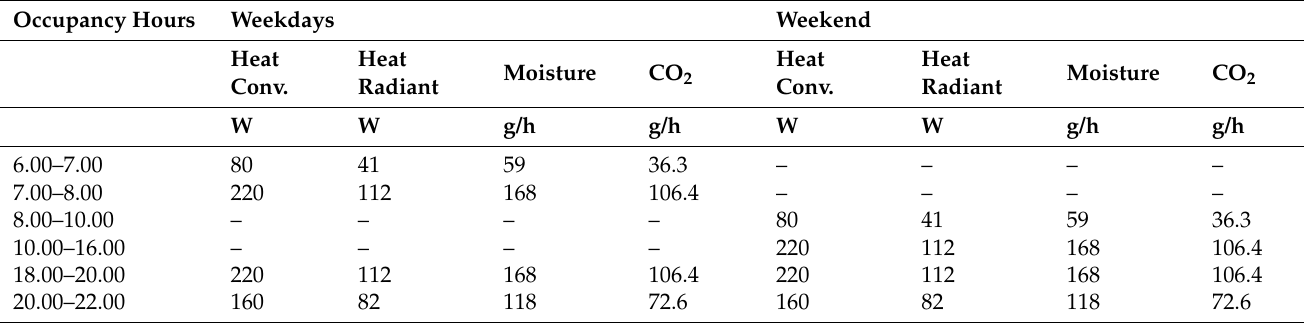
Table 3. Occupancy schedule with internal heat